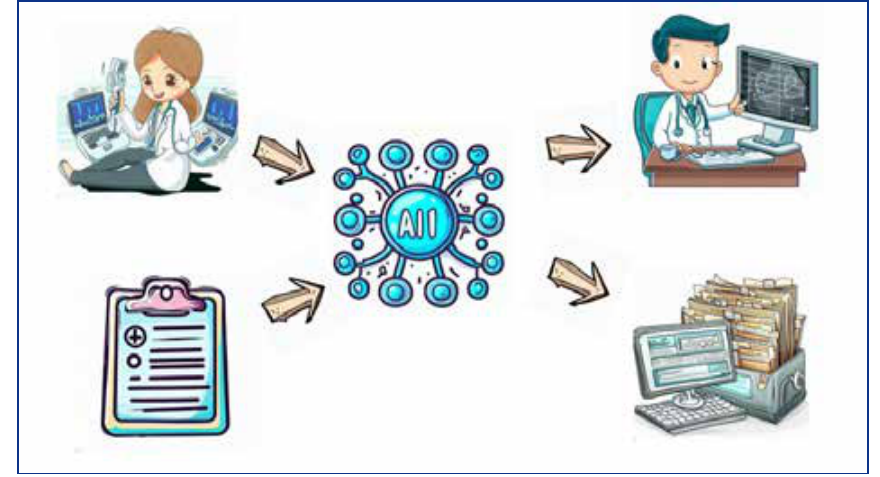
Figure 2 Cloud handheld ultrasound work flow. Patients are registered online and then scanned. The on-device AI screens for potential positives, which are then manually uploaded for further inspection and diagnosis.